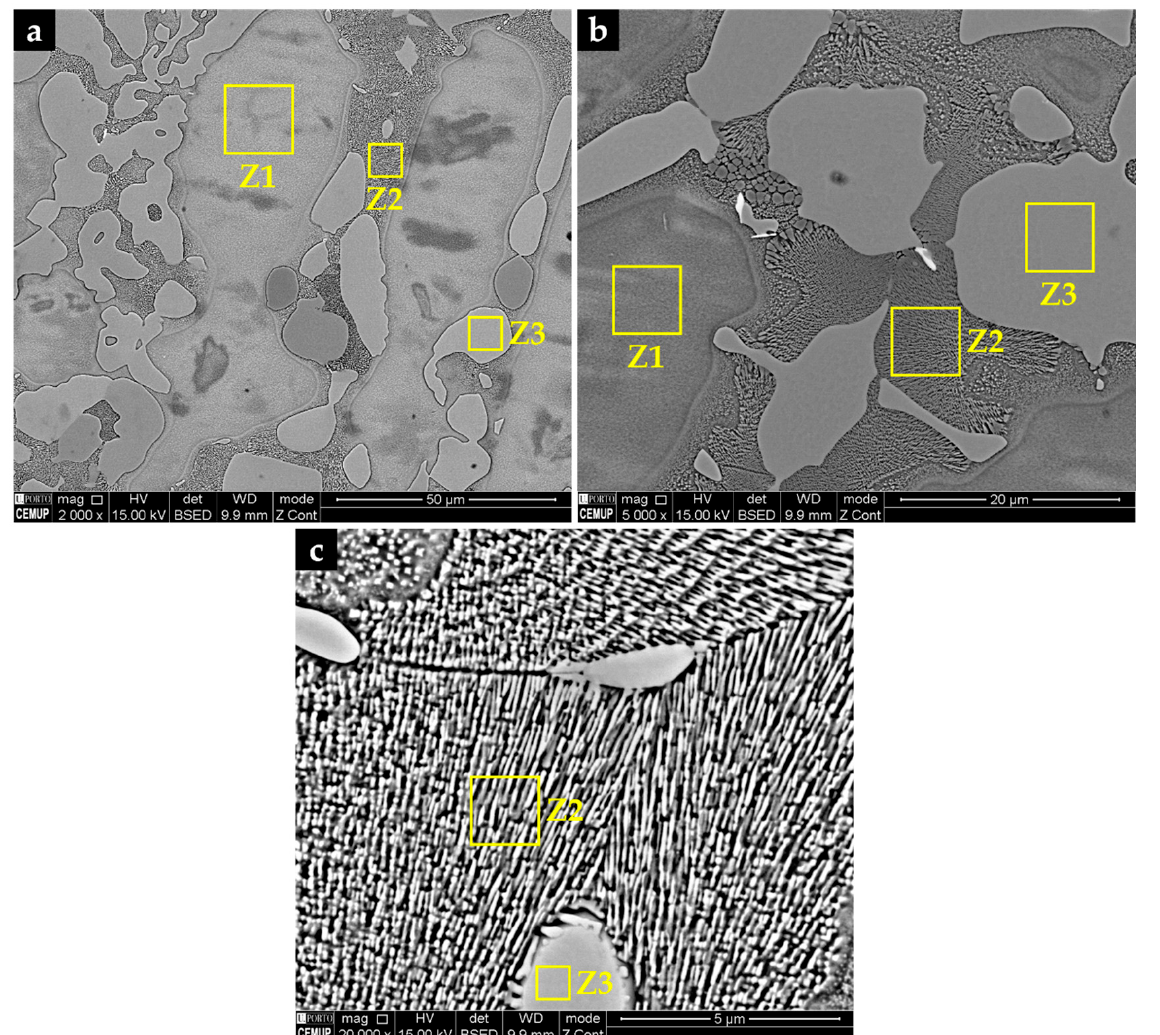
Figure 2. ( a ) SEM-BSE images of the as-cast microstructure of NiSi3B2 alloy showing the nickel-austenite (Ni- γ ) as Z1, eutectic constituent (Ni- γ -Ni 3 Si) as Z2, and nickel borides (Ni 3 B) as Z3; ( b ) the same as ( a ) at a higher magnification; ( c ) the fine eutectic constituent Z2 is more clearly shown at a higher magnification.